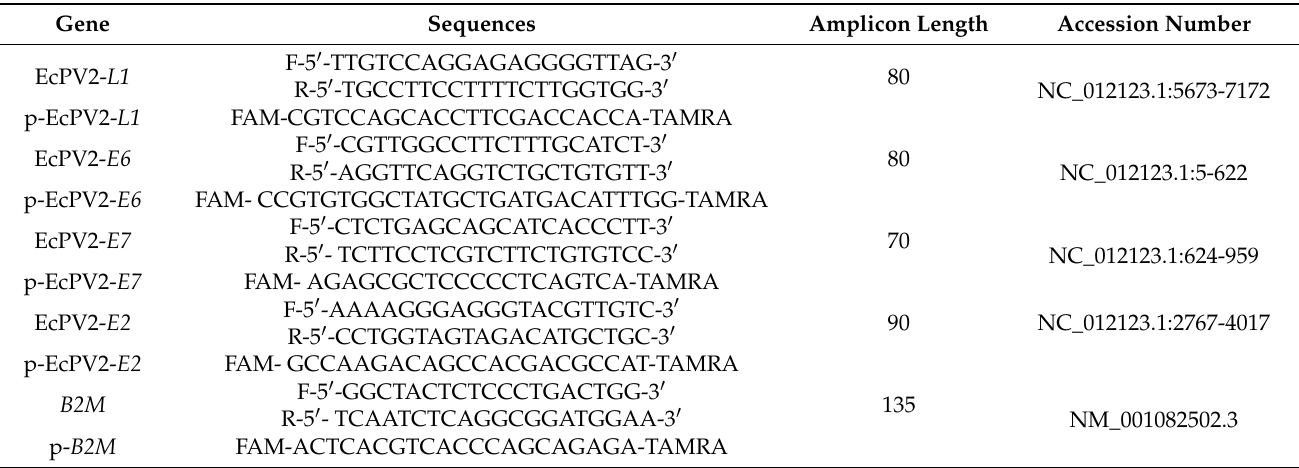
Table 1. Primer sets and probes for DNA and gene expression